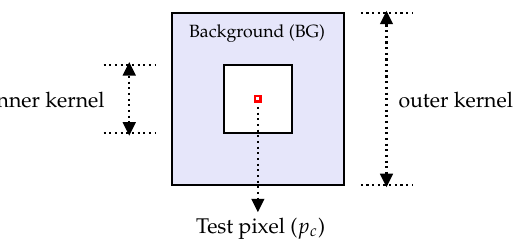
Figure 4. Illustration of the CFAR filter window (modified from [12]).